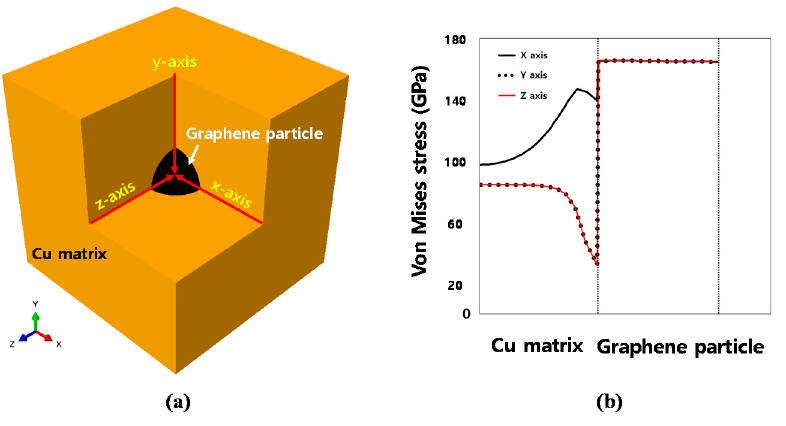
Figure 12. Macroscopic stress variations in the graphene/Cu composites: ( a ) directions; ( b ) Von Mises stress.